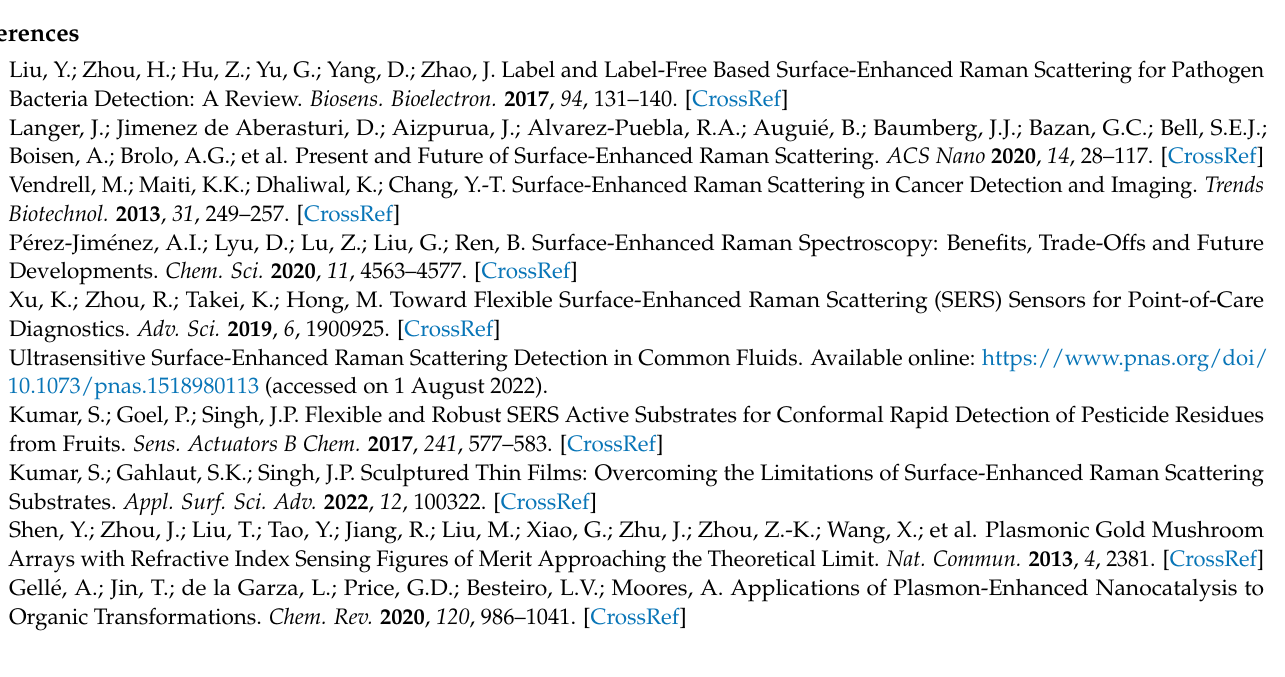
Figure S1: The fabricated nanoporous Ag-decorated Ag 7 O 8 NO 3 micro-pyramids on ITO glass (2 cm × 0.5 cm) (left) and the actual substrate cut down for SERS detection (0.5 cm × 0.5 cm) (right). Figure S2: The X-ray diffraction pattern of the electrodeposited materials. Figure S3: Energy- dispersive X-ray (EDX) mapping images of electrodeposited materials. Figure S4: SEM images of the Ag 7 O 8 NO 3 micro-pyramids’ morphology evolution under the different electrodeposition voltage. Figure S5: SEM images of the Ag 7 O 8 NO 3 micro-pyramids’ morphology evolution under different electrodeposition time. Figure S6: Energy-dispersive X-ray (EDX) mapping images of nanoporous Ag-decorated Ag 7 O 8 NO 3 micro-pyramids. Figure S7: SERS signals of R6G (10 − 6 M) collected from nanoporous Ag-decorated Ag 7 O 8 NO 3 micro-pyramids reduced by using NaBH 4 solution with different concentrations. Figure S8: Morphology of nanoporous Ag-decorated Ag 7 O 8 NO 3 micro-pyramids reduced using 5 mM NaBH 4 solution. Figure S9: SERS signals of R6G (10 − 7 M) collected from Ag 7 O 8 NO 3 micro-pyramids and Ag 7 O 8 NO 3 micro-pyramids by chemical reduction. Figure S10: SERS spectrum of 10 − 11 M R6G absorbed on the nanoporous Ag-decorated Ag 7 O 8 NO 3 micro-pyramids, and the normal Raman spectrum of R6G polyvinyl chloride film. Figure S11: Raman spectra of CV (10 − 5 M) and thiram (10 − 5 M), and the RSD values of 1618 cm − 1 (CV) and 1384 cm − 1 (thiram) peaks, respectively. Table S1: Comparison of LODs between various SERS